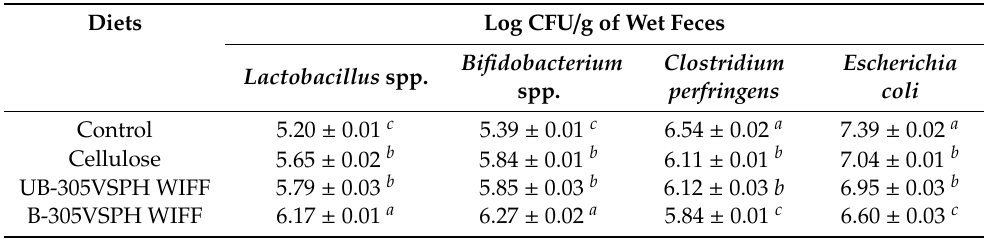
Table 7. Viable bacterial counts in the fecal content of hamsters fed diets with cellulose or WIFF of UB-305VSPH and